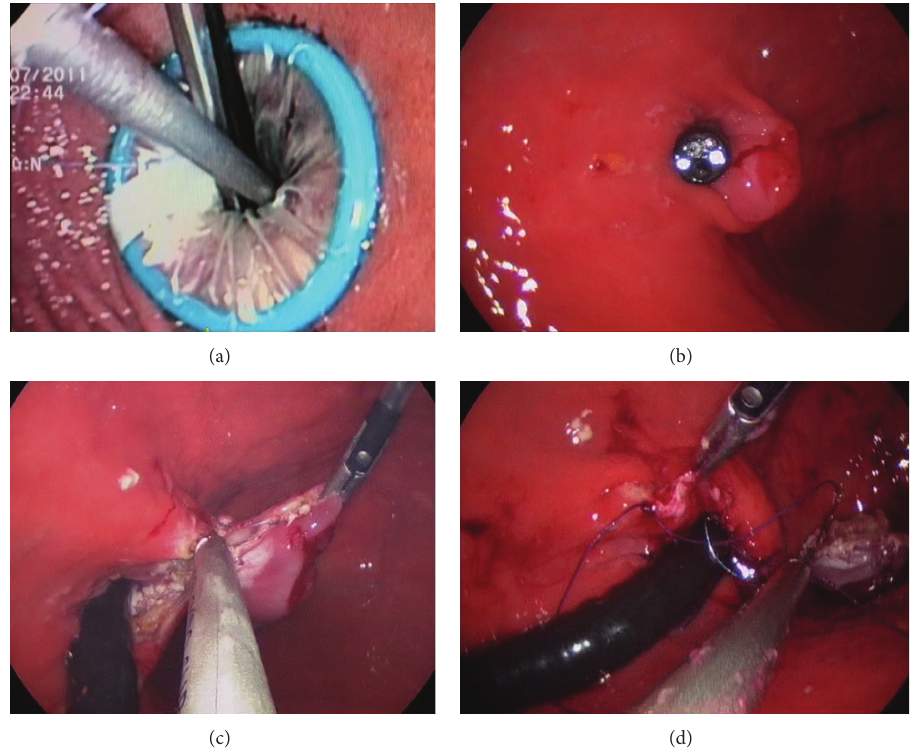
Figure 2: (a) Intragastric endoscopic vision of laparoscopic devices through Triport. (b) Location of tumor at esophagogastric junction. (c) Resection of tumor assisted by traction of the cardias performed with the gastroscope. (d) Closure of mucosal defect.